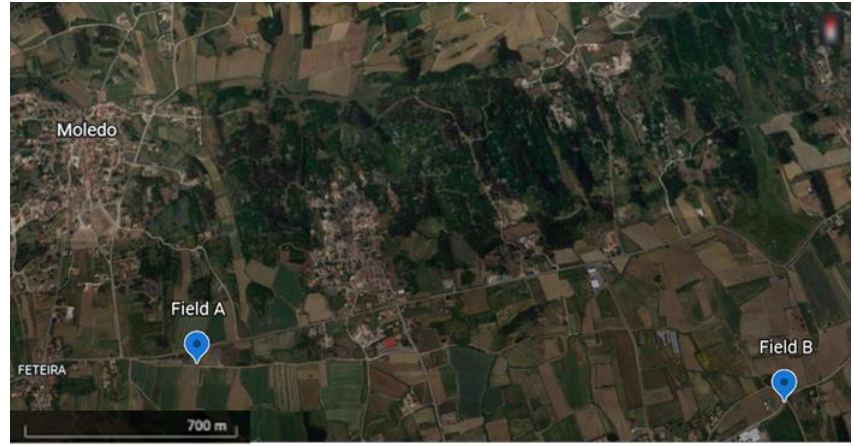
Figure 1. Geographic location of the two experimental fields (Field A and B) (images obtained through Google Earth). Field A—GPS coordinates: 39°16′39′’ N 9°15′08′’ W (142 m) and Field B—GPS coordinates: 39°16′31′’ N 9°13′47′’ W (182 m).